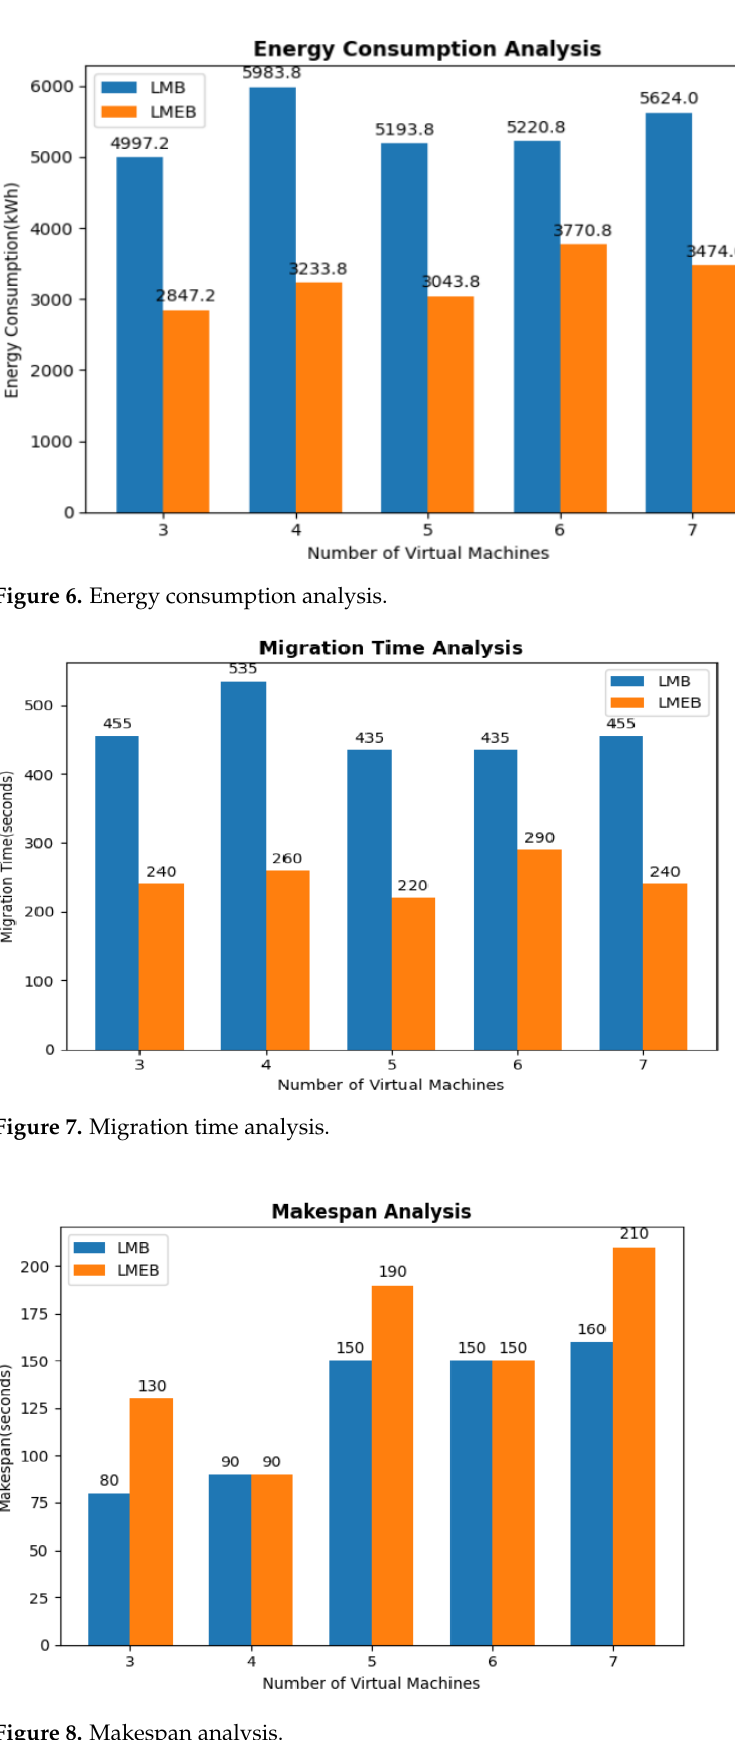
Table 9. Migration time for all scenarios in seconds.